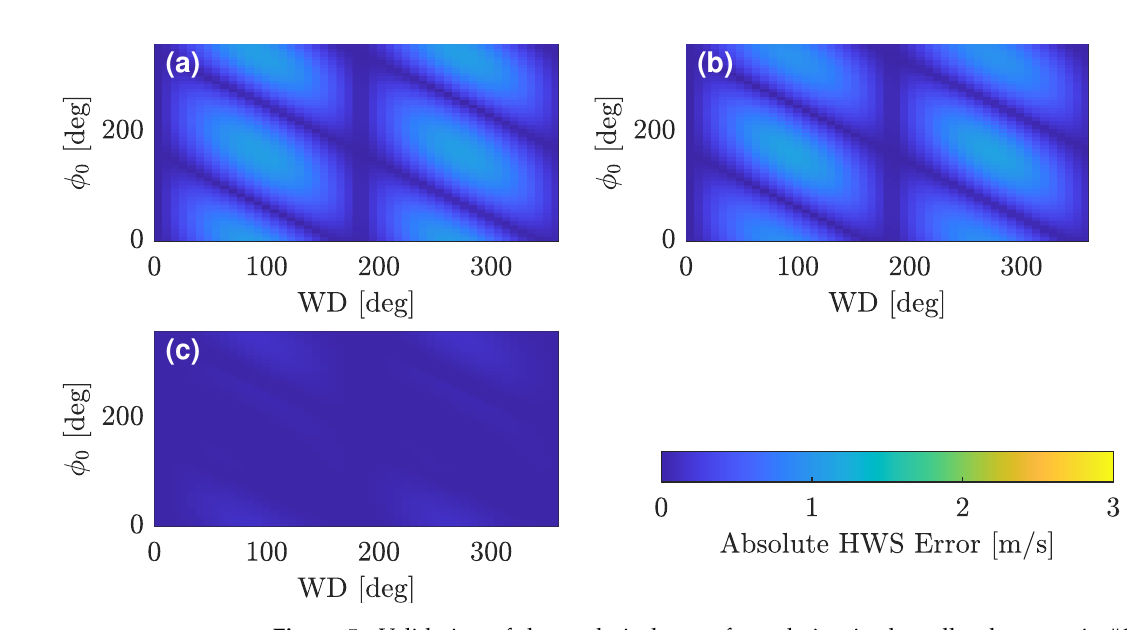
Figure 5. Validation of the analytical-error formulation in the roll-only scenario #1: HWS error (parameters: A roll = 10 deg, f roll = 0.3 Hz and α r oll = 0 deg. Input wind: HWS = 10 m/s, VWS = 0 m/s). ( a ) The analytically estimated HWS error as a function of the wind direction (WD) and the initial scan phase ( φ 0 ). ( b ) The simulator-estimated HWS error. ( c ) The difference of ( a ) minus ( b ) (in absolute value).